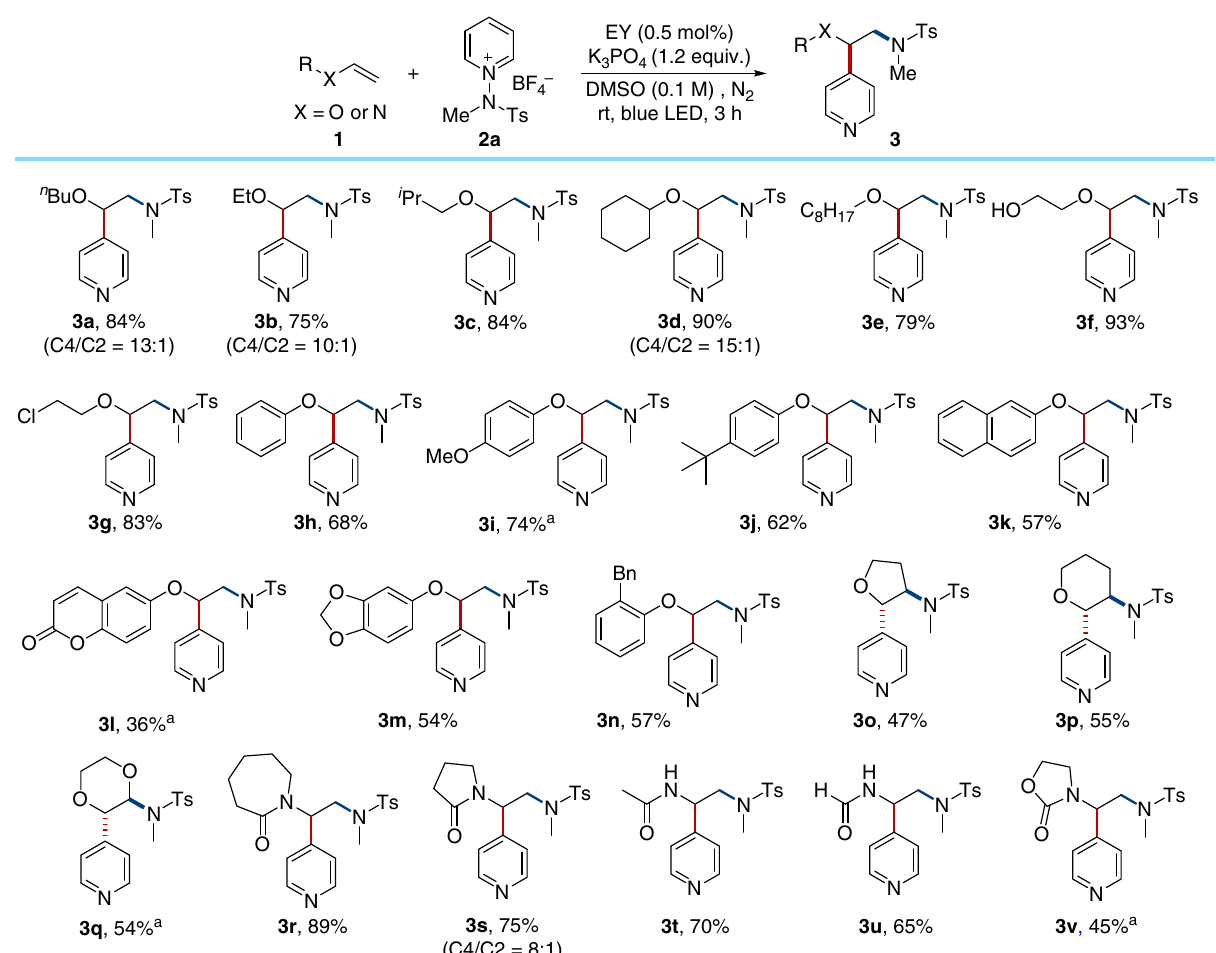
Fig. 5 Substrate scope of alkenes. Reaction conditions: 1 (0.1 mmol), 2a (0.15 mmol), EY (0.5 mol%), K 3 PO 4 (0.12 mmol), and DMSO (1.0 mL) using blue LEDs at rt for 3 h under N 2 . Yields of isolated products. C4/C2 ratio was measured by 1 H NMR spectroscopy. Unless indicated, C4/C2 > 15:1. a